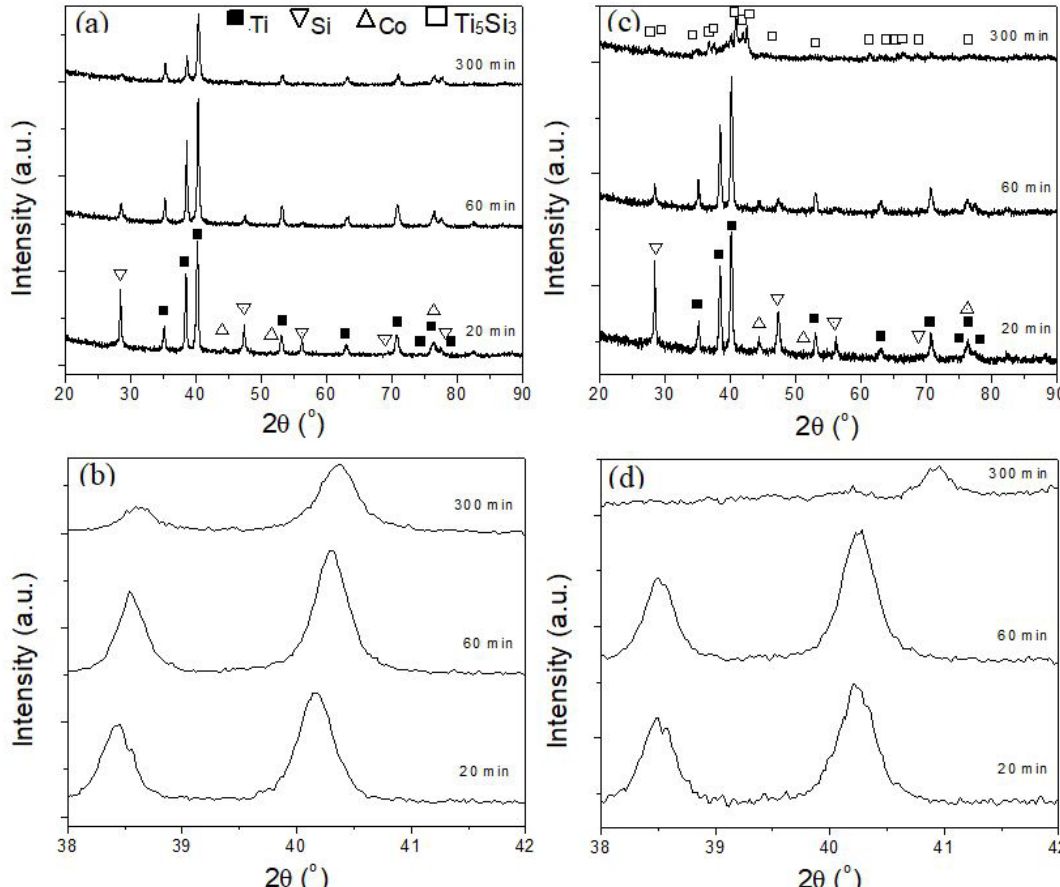
Figure 1. XRD patterns of (a,b) Ti-2Co-22Si-11B and (c,d) Ti-6Co-22Si-11B powder mixtures at different milling times, and their details on their major α -Ti peaks are illustrated in (b) and (d),